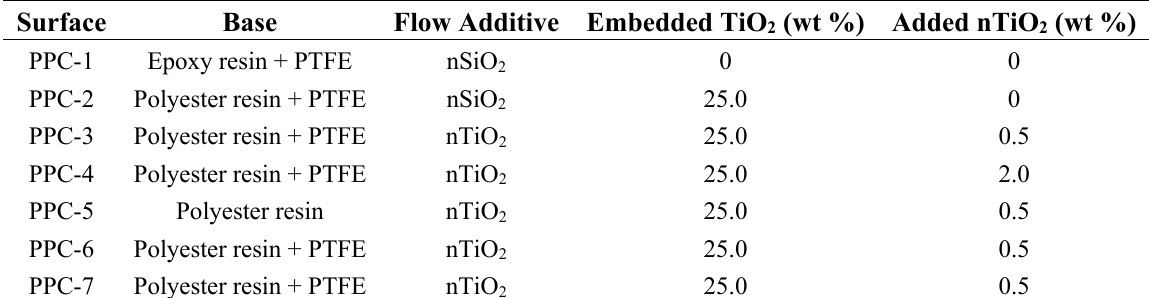
Table 2. Example of coated surface chemical